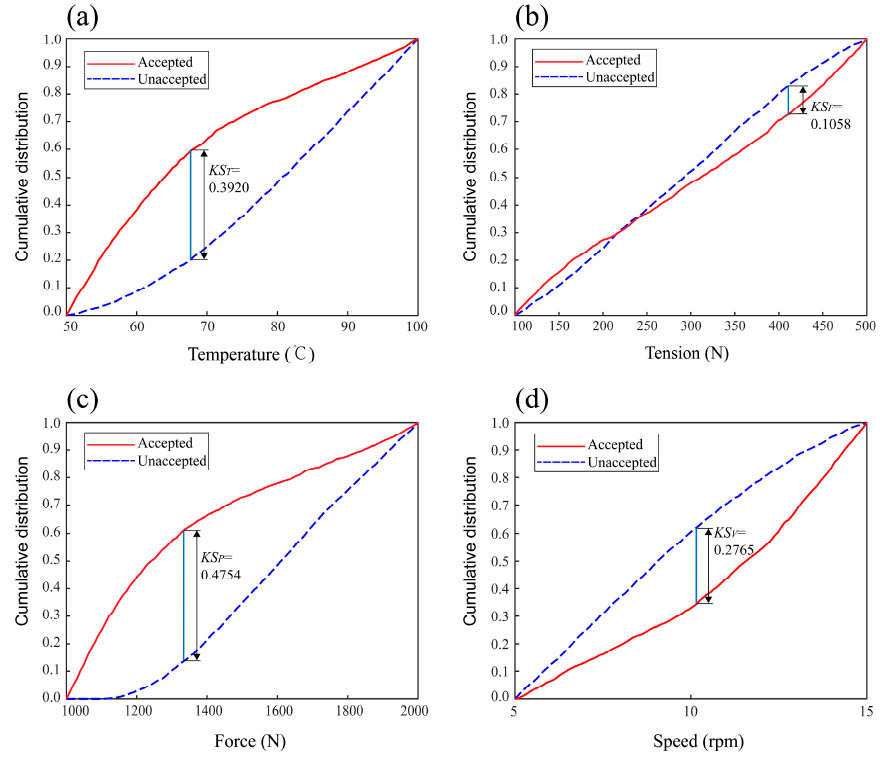
Figure 9. Results of GMSA for the void content model. ( a ) Temperature, ( b ) Tension, ( c ) Force, ( d ) Speed.